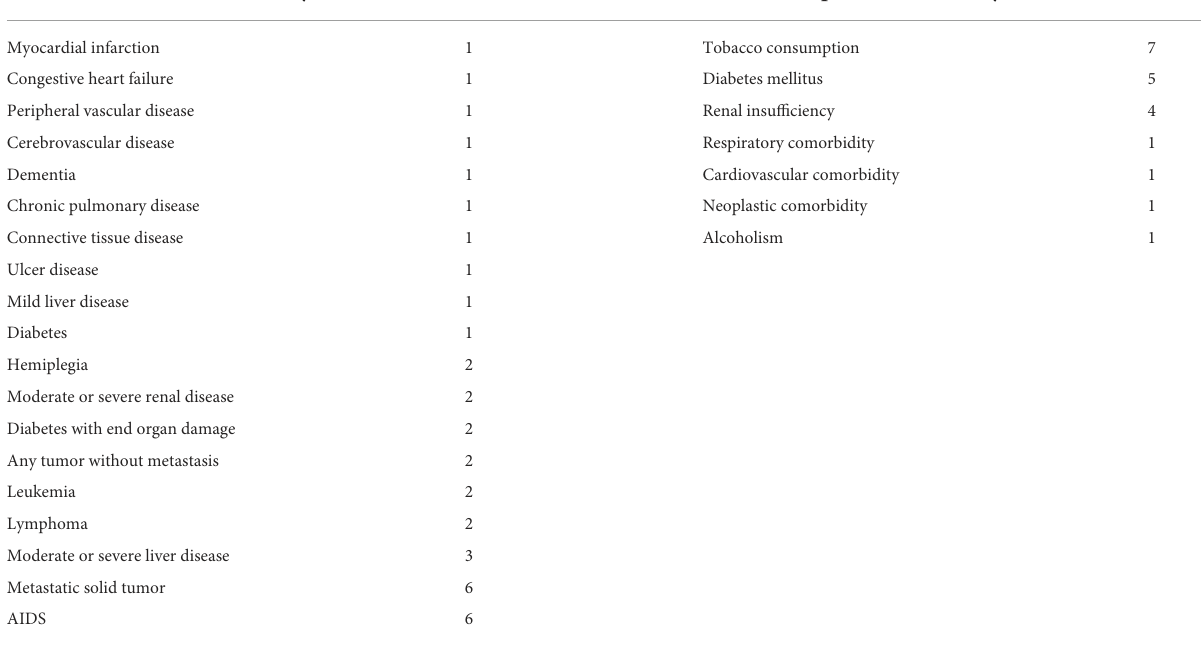
TABLE 1 The comparison of the main mentioned indexes used for prognosis in lung cancer (2, 3). Charlson comorbidity index